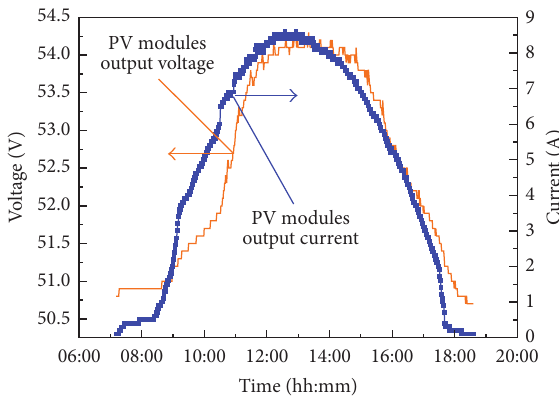
Figure 9: Voltage and current variations of PV modules.